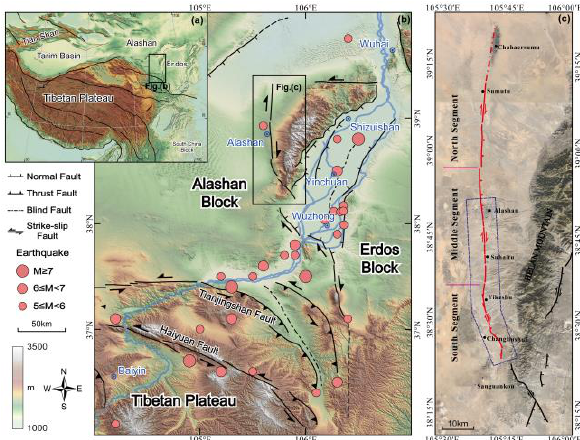
Figure 1. (a) Tectonic location of the Helan Mountain which is located at the junction of the Tibetan Plateau, Alashan, and Ordos blocks. (b) Tectonic map of the West Helanshan Fault showing the locations of major active faults and historical earthquakes (M≥5) in surrounding areas. The base map is the 90 m SRTM (Shuttle Radar Topography Mission) hillshade map.